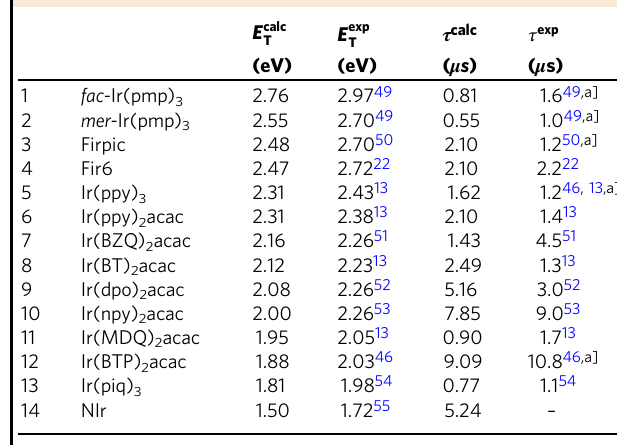
Table 1 Calculated and experimental triplet energies and lifetimes.